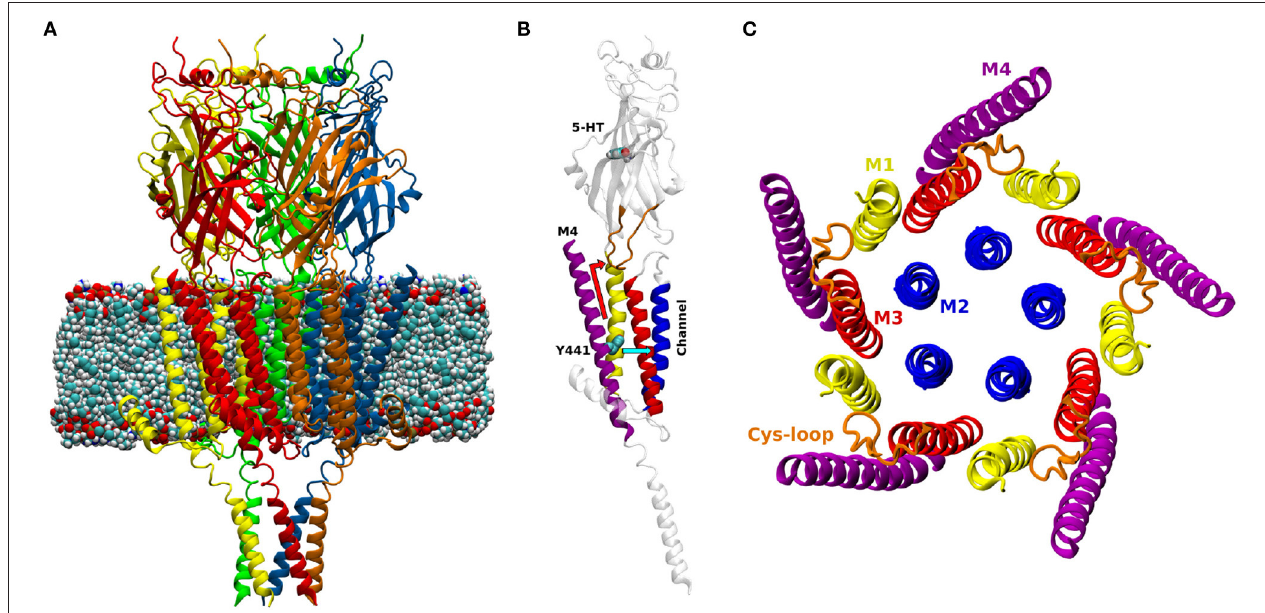
FIGURE 1 | (A) Model of the open structure of the 5-HT 3A receptor (PDB ID 6DG8, Basak et al., 2018a) embedded in a lipid membrane. The five subunits are colored in red, yellow, green, blue and orange. (B) One subunit of the 5-HT 3A receptor; M1: yellow, M2: blue, M3: red, M4: purple, Cys-loop: orange. The atoms of 5-HT and residue Y441 are shown as spheres. The two possible paths of Y441A action are shown in light blue ( radial ) and red ( vertical ). (C) View orthogonal to the channel axis of the transmembrane domain of the 5-HT 3A